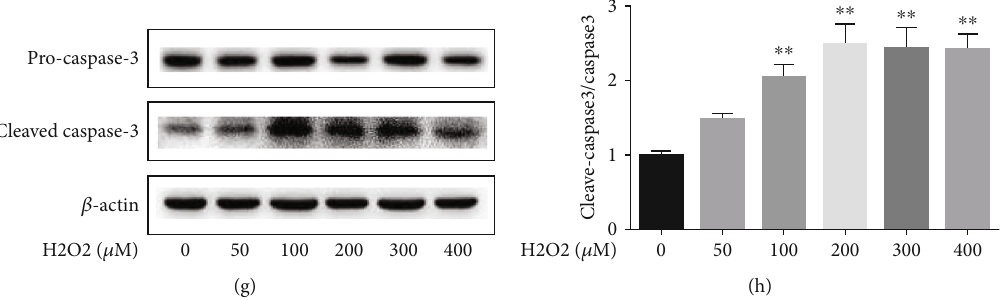
Figure 2: Plin2 levels increase after hydrogen peroxide treatment in primary renal proximal tubular cells. Primary renal proximal tubular cells were treated with hydrogen peroxide. (a, b) Cell viability measured using CCK-8 assays after hydrogen peroxide treatment ( n = 10 ). ∗ P < 0 : 05 vs. 0h or 0 μ M hydrogen peroxide. (c) Images of mitochondrial reactive oxygen species (ROS) generation after hydrogen peroxide treatment for 12 hours. (d) Quantitative RT-PCR analysis of Plin2 mRNA expression after hydrogen peroxide treatment for 12 hours ( n = 4 ). ∗ P < 0 : 05 vs. 0 μ M hydrogen peroxide. (e – h) Western blot analysis of Plin2, BAX, Bcl-2, and cleaved caspase-3 expressions after hydrogen peroxide treatment for 12 hours ( n = 4 ). ∗ P < 0 : 05 vs. 0 μ M hydrogen peroxide; ∗∗ P < 0 : 01 vs. 0 μ M hydrogen peroxide; and ∗∗∗ P < 0 : 001 vs. 0 μ M hydrogen peroxide. Data are presented as mean ± SEM . H O : hydrogen 2 2